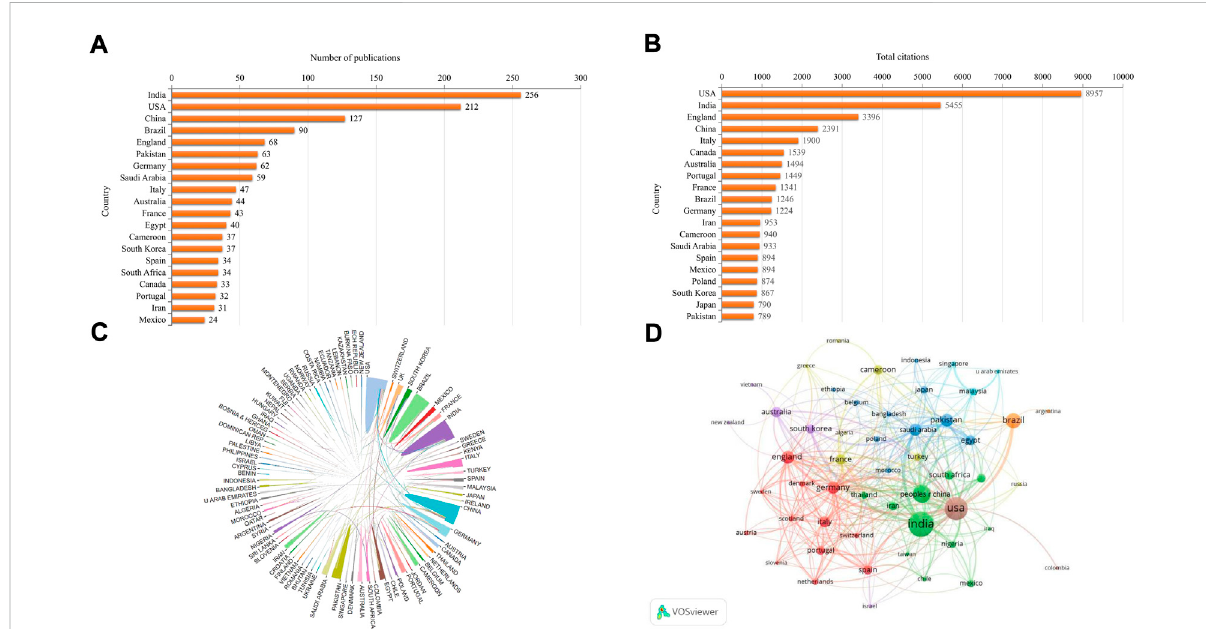
FIGURE 3 Geographical distributionand international cooperation of countries/regions related to resistance of natural products to MDR bacteria. (A) Top 20 countries/regions with the largest number of publications. (B) Top 20 countries/regions with the largest number of citations. (C) International cooperation among all countries/regions. (D) Network visualization map of co-authorship among countries/regions with 5 or more publications.